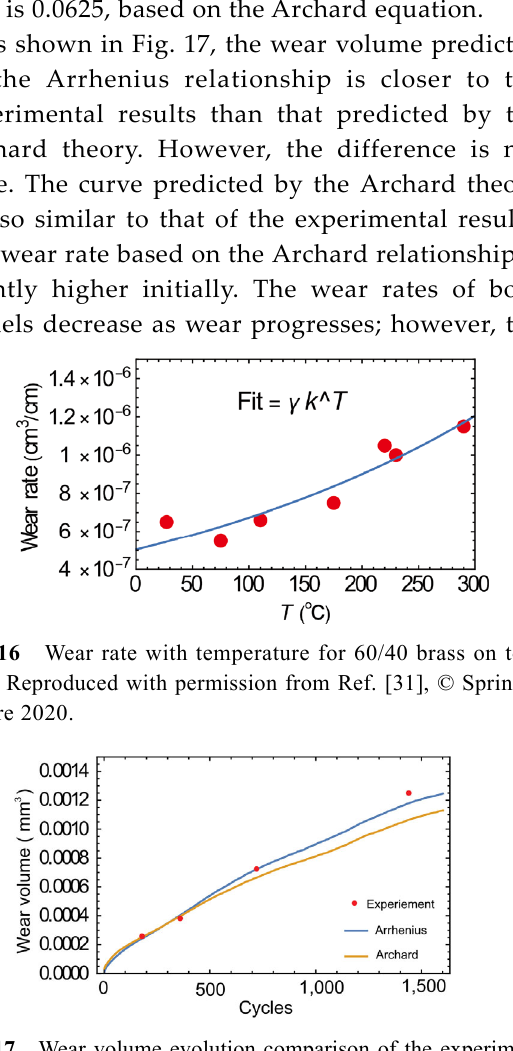
Fig. 15 (a) Wear volumes vs. cycles and (b) wear rate vs. temperature.